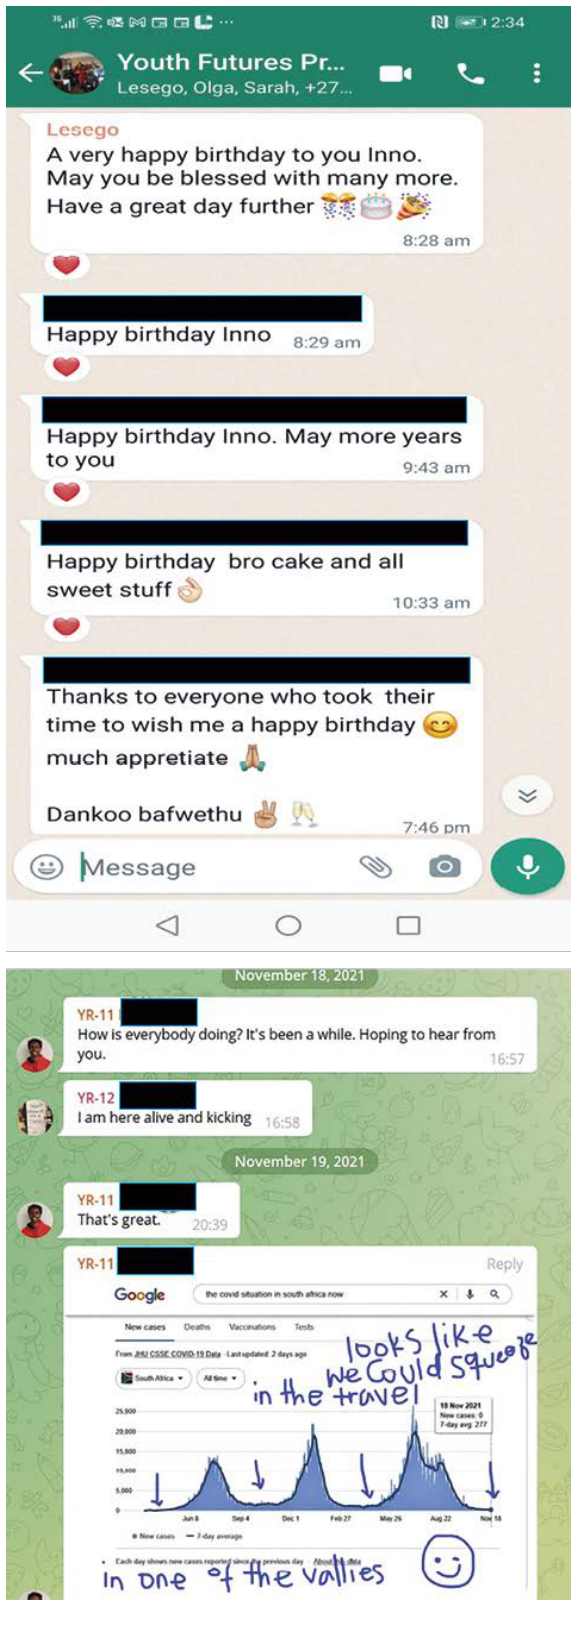
Figure 3. Social interaction on the whatsapp and telegram